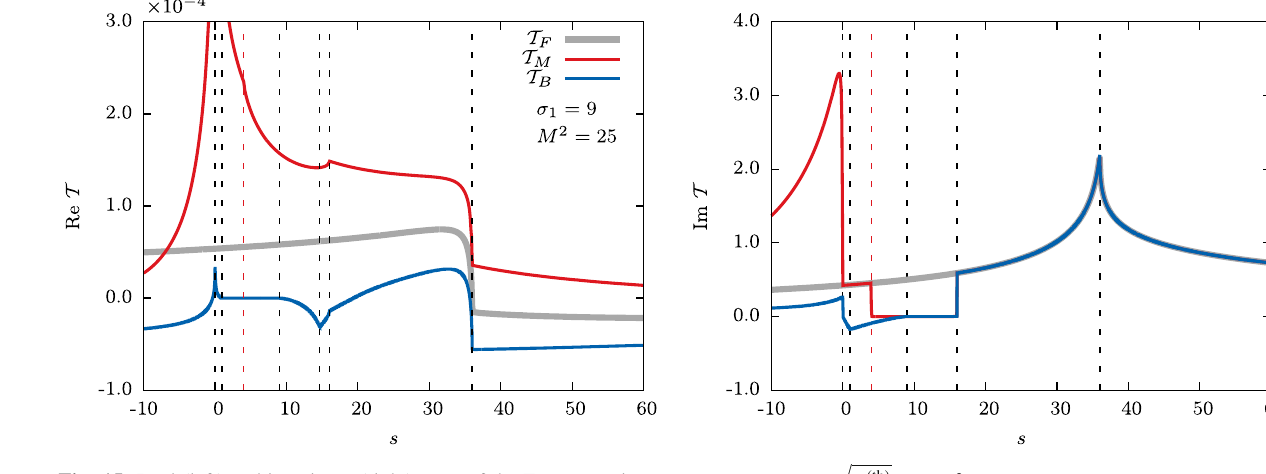
Fig. 15 Real (left) and imaginary (right) parts of the Feynman trian- gle diagram, Eq. (56) (gray), the B -matrix triangle, Eq. (54) (blue), and the Mai et al. triangle, Eq. (57) (red). The external masses are set to unity, and the external isobar masses are σ (cid:6) The dashed vertical lines indicate the locations of singularities in the B -matrix as described in the text: (from left to right) the s = 0 sin- gularity (where the explicit 1 / s pole in ρ 3 ( s ,σ (cid:6)(cid:6)